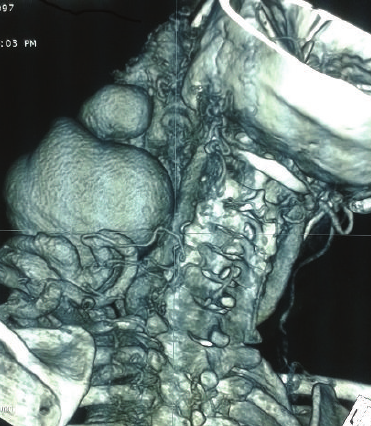
Figure 3: CT scan. Posterior view of cervical AVM showing connections with vertebral.